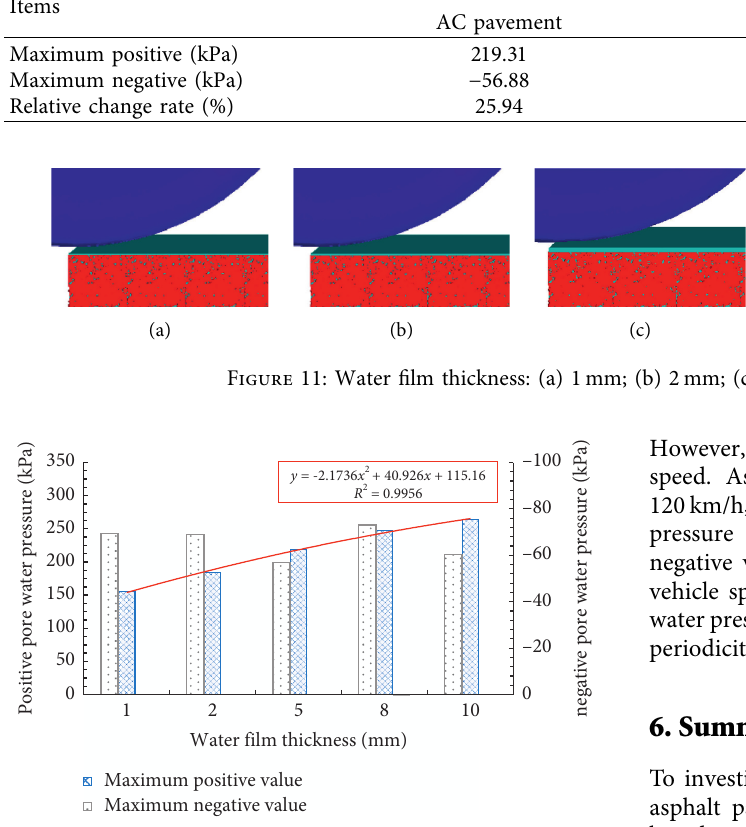
Figure 12: Maximum hydrodynamic pressure with different water film